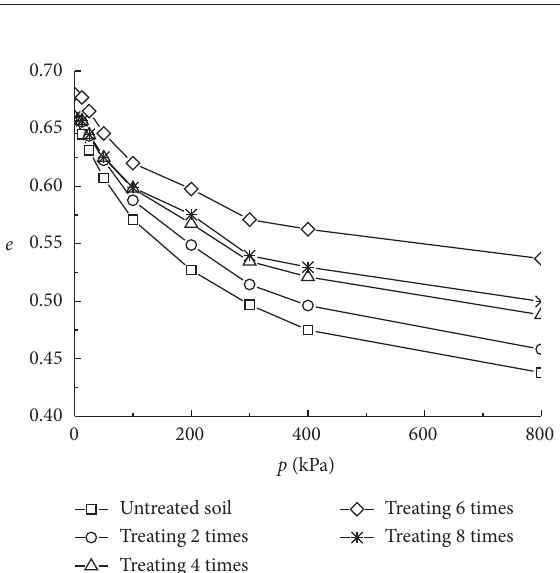
Figure 1: e- p curves of the expansive